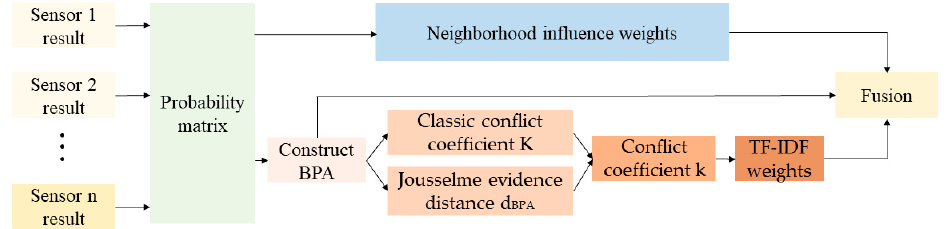
Figure 3. Intermediate visual effects of the proposed decision fusion method.